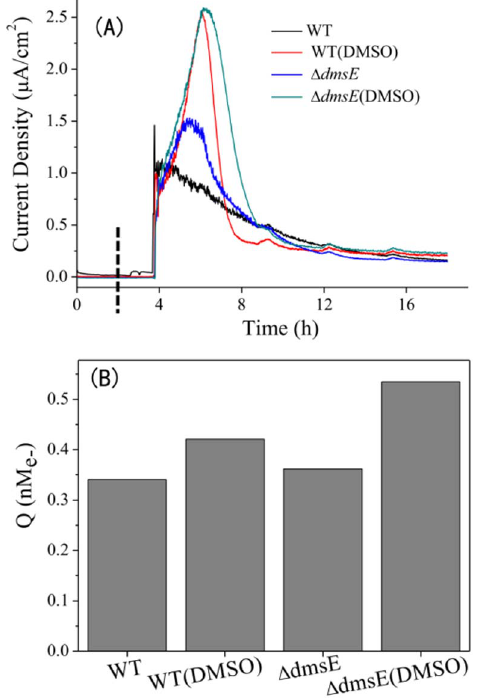
Figure 5. Electricity currents generation in bioelectrochemical system. Current generated by WT and the D dmsE in electrochemical cells (A) and the coulomb integral of each electrochemical cell across the test period (B). The potential of working electrodes was set at + 0.15 V (versus Ag/AgCl). DMSO was dosed at 0.5 mM. Microbial cells were inoculated to the OD600 of 0.5 at given time point, which is indicated by dotted line. The experiment was conducted three times and consistent results were